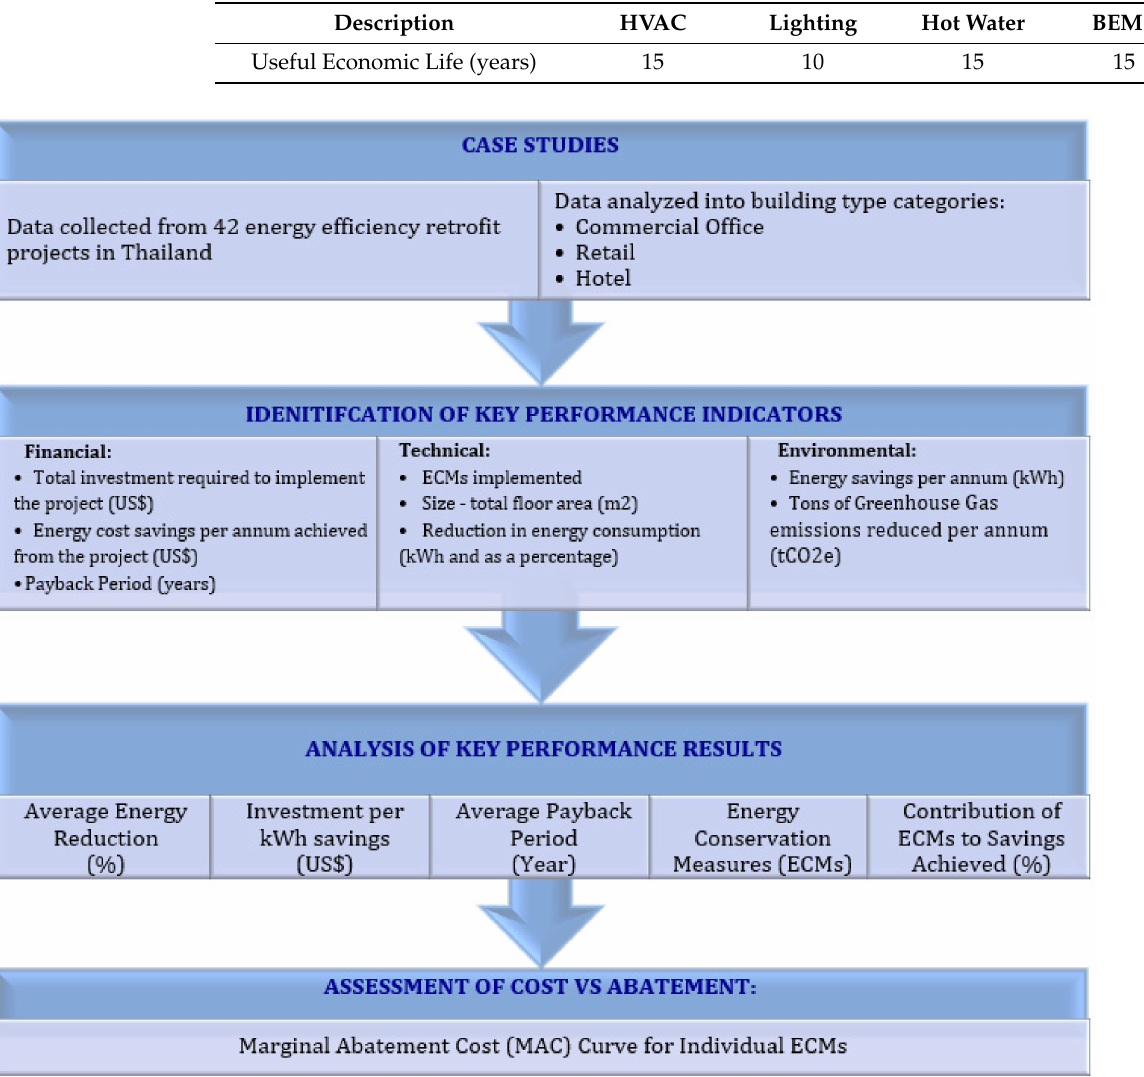
Table 2. Useful economic life of ECMs (years).